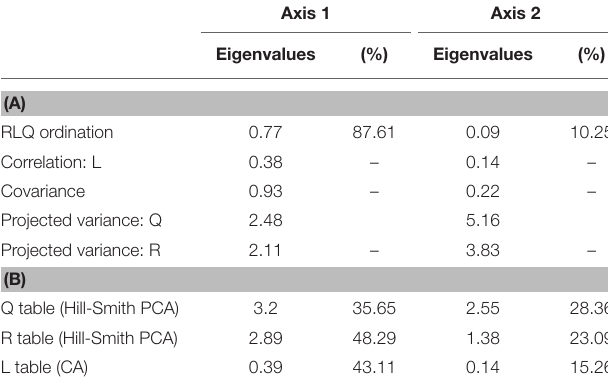
TABLE 2 | Summary of the RLQ